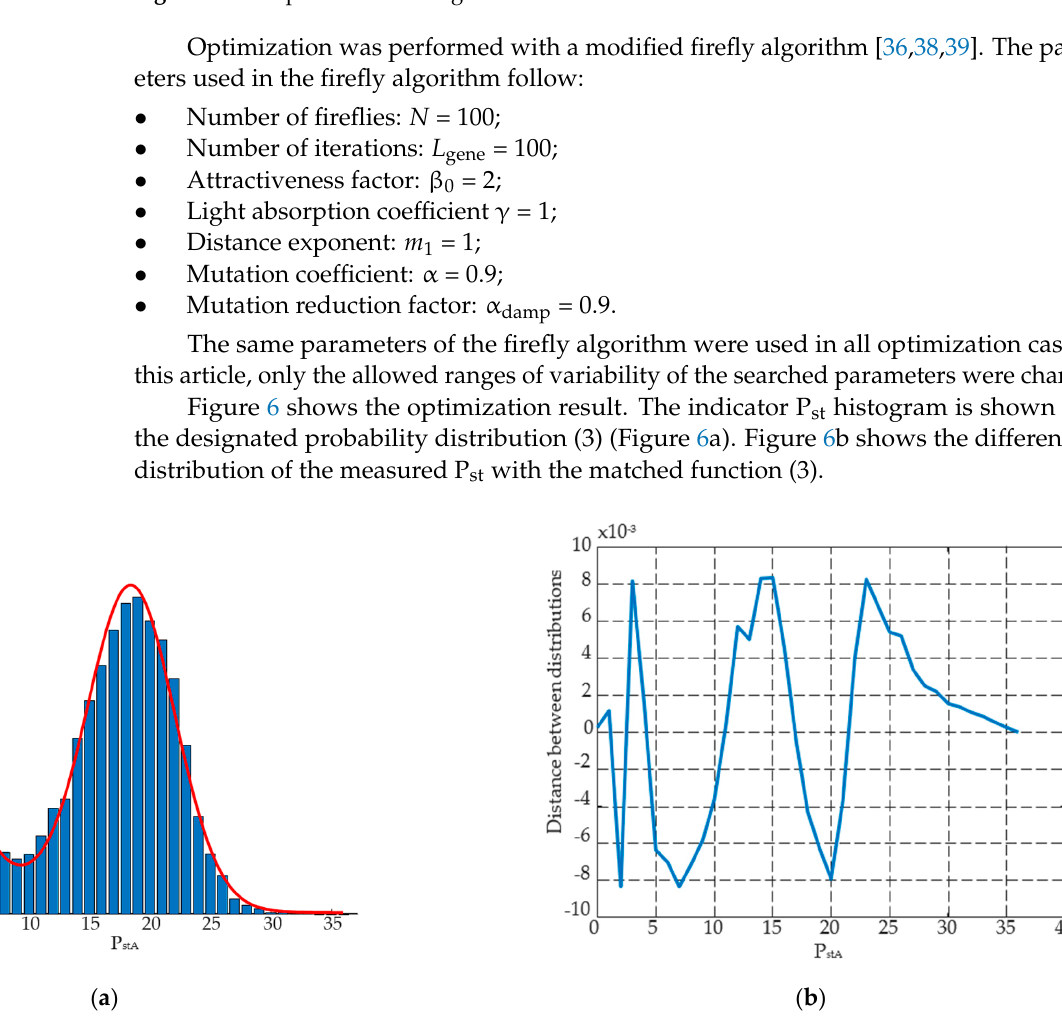
Figure 6. Adjustment of the P st indicator density distribution for a voltage of 30 kV: ( a ) histogram with the determined distribution, ( b ) differences between distributions. Table 2 summarizes the determined distribution parameters (3). Table 2. Parameters of the determined distributions.